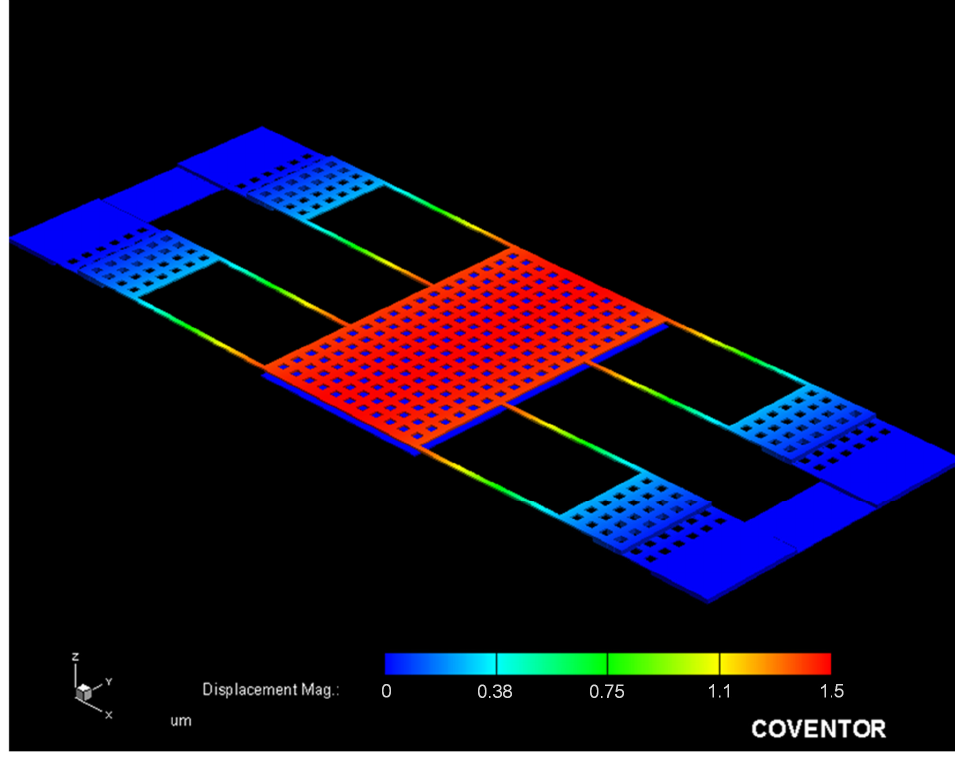
Figure 3. Simulation of membrane displacement for the MSS.